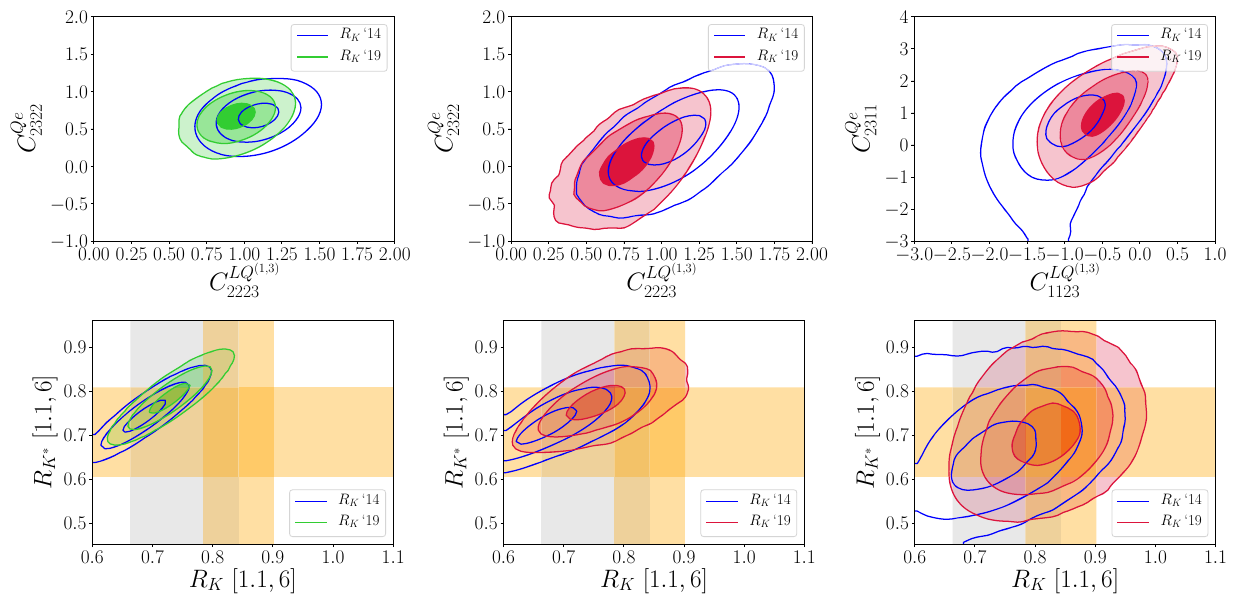
, C NP ) andcombined Fig. 2. We show the result in the SM gauge-invariant language, for both 9 10 the muonic (left and central column) and electronic (right column) case